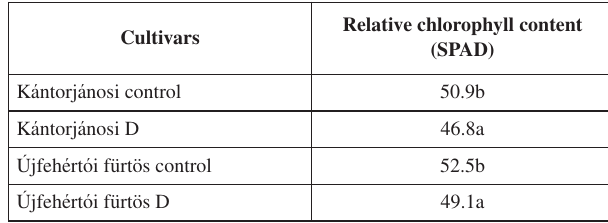
Table 2. Relative chlorophyll contents (SPAD) of investigated leaves